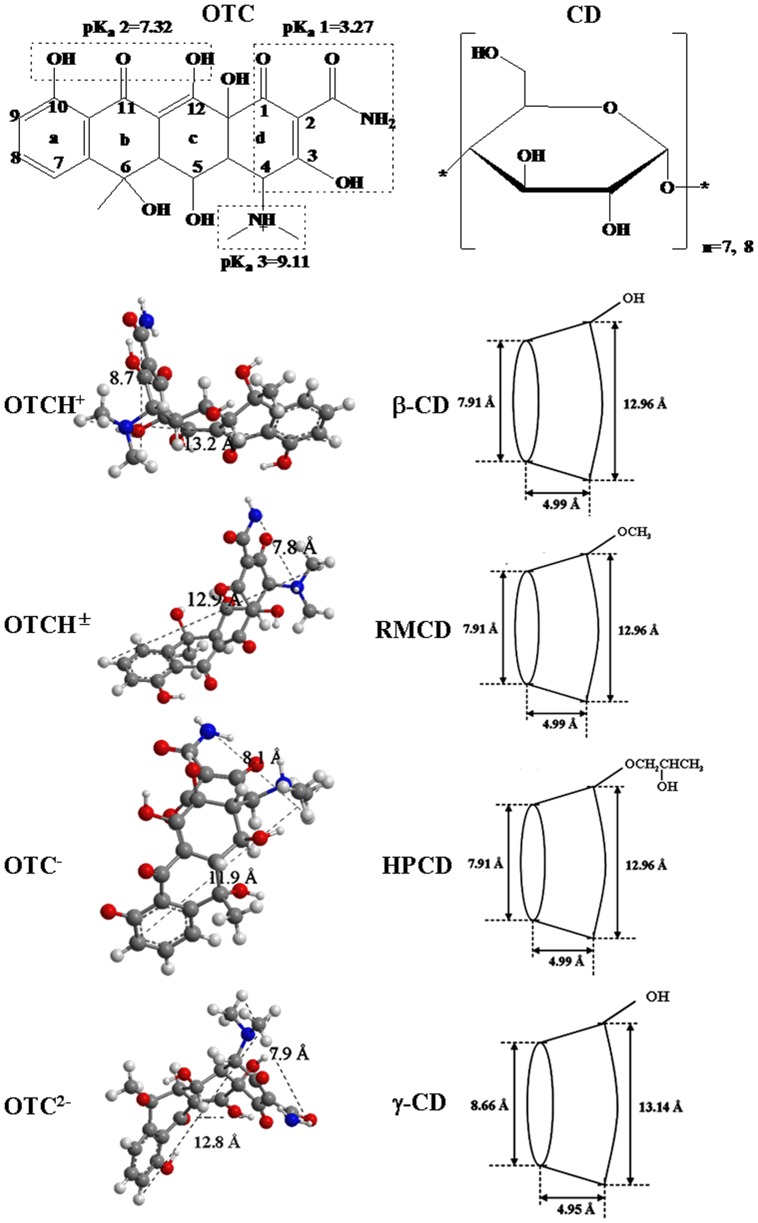
Molecular geometry of OTC species and CD [39].